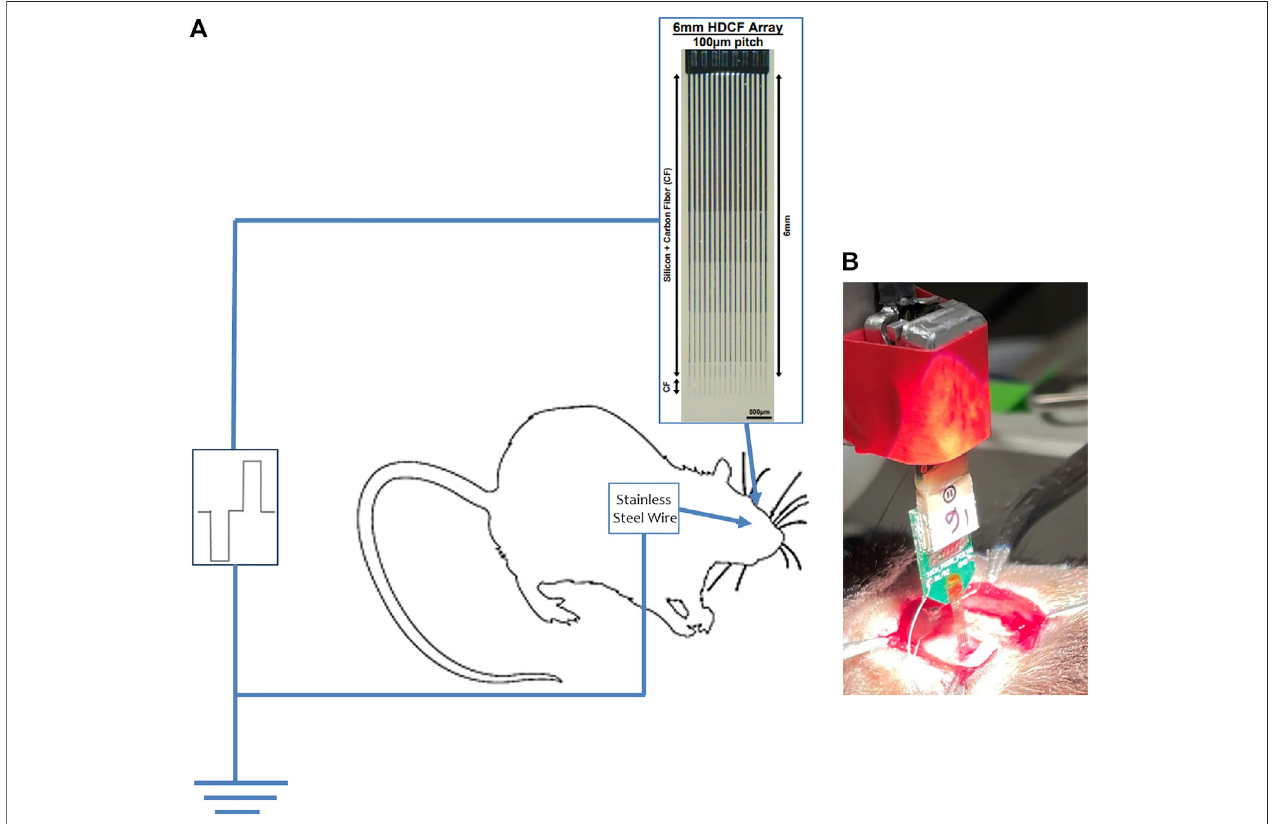
FIGURE 1 | In vivo stimulation setup. (A) Explaining the in vivo setup with the HDCF array penetrating the visual cortex and the stainless steel wire as ground, both connected to the Plexim stimulator. (B) Image of the HDCF array penetrating the visual cortex.